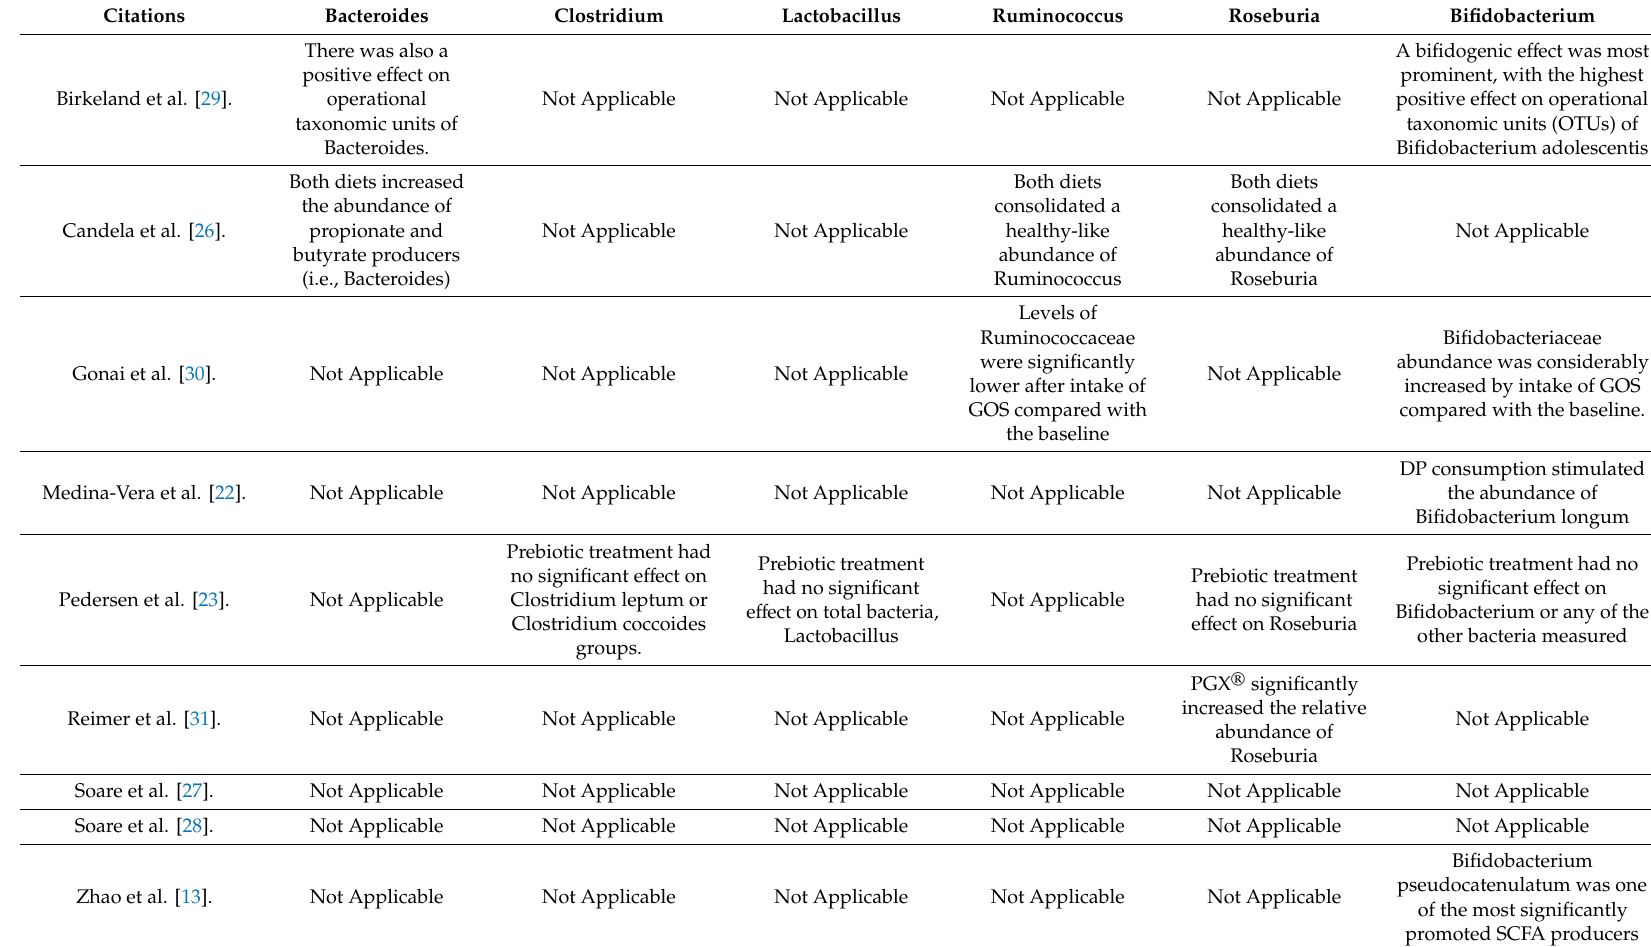
Table 3. The e ff ect of dietary fibre on gut microbiota at the genus